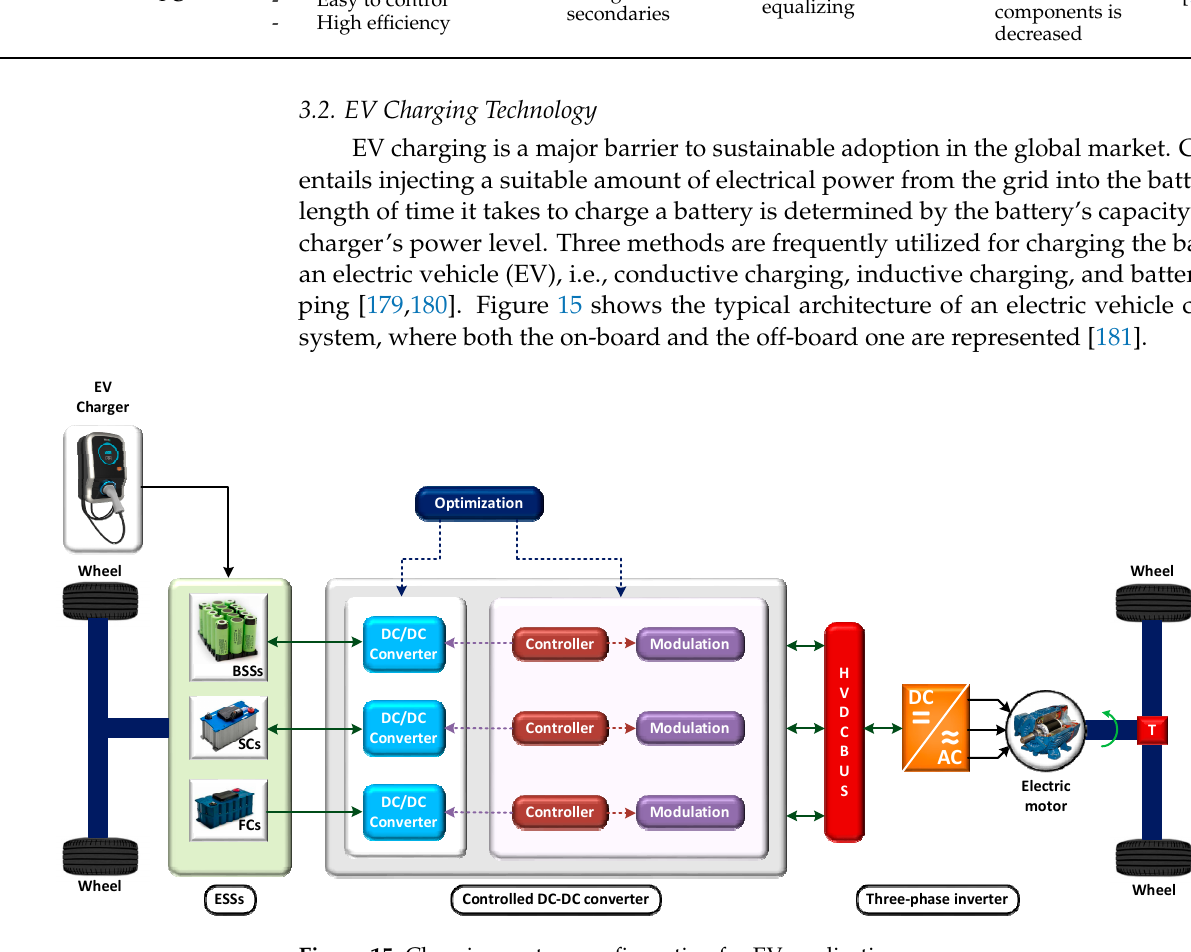
Figure 15. Charging system configuration for EV applications.